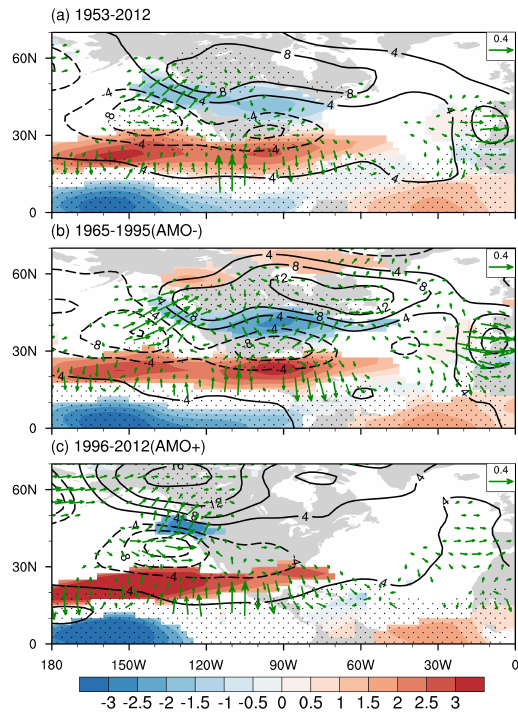
Figure 6. Regression coefficients of 500-hPa geopotential height (contour; units: gpm) and 300-hPa zonal wind (shading; units: m/s) onto the Niño3.4 index in spring together with the corresponding wave activity flux (vector; units: m 2 /s 2 ) during: ( a ) 1953–2012; ( b ) 1965–1995 (AMO − ); and ( c ) 1996–2012 (AMO+). The solid and dashed contours represent positive and negative values, respectively, with an interval of 4 gpm; and the zero isoline is omitted for clarity. Stippling represents geopotential height anomalies exceeding the 95% confidence level. Only zonal wind anomalies exceeding the 95% confidence level and the WAF with its amplitude exceeding 0.05 m 2 /s 2 are plotted. Red and blue shading represents the positive and negative regression coefficients exceeding the 95% confidence level,